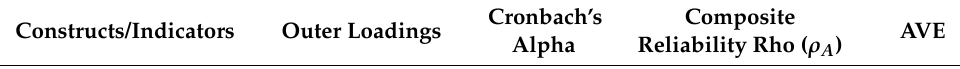
Table 2. Results for reflective measurement